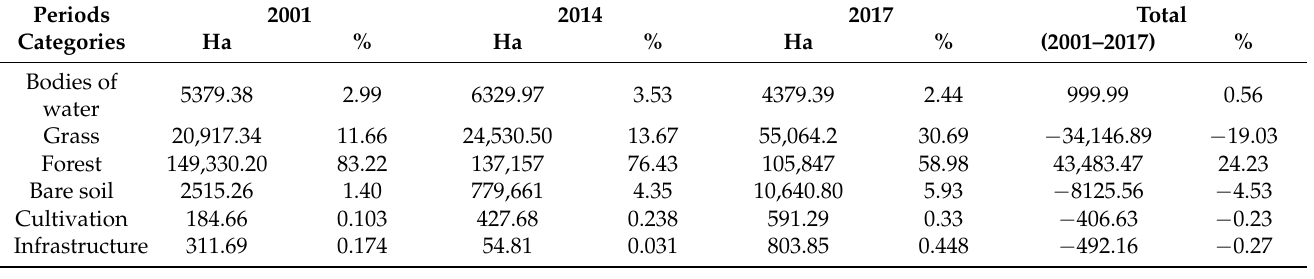
Table 4. Area in hectares for each category in the ITT Oil Block of the three periods.